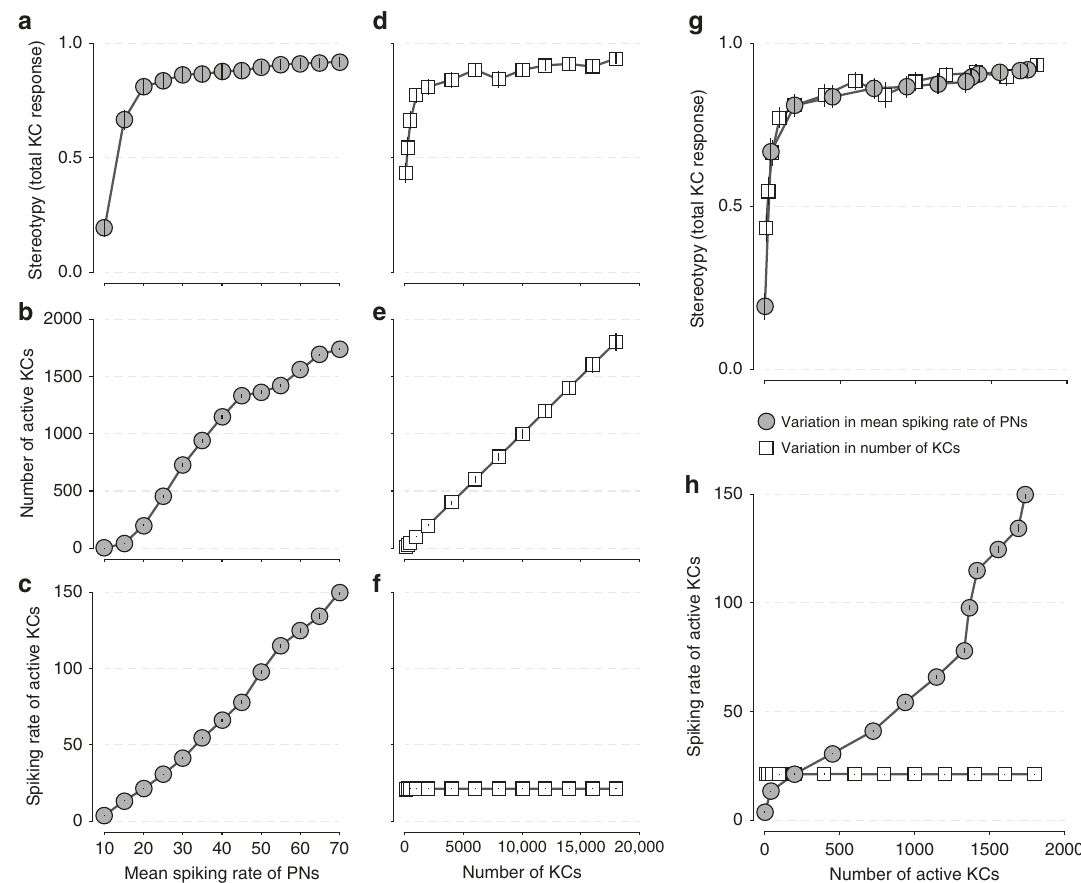
Fig. 6 The number of active KCs but not their spiking rate determines stereotypy. a – c Stereotypy in total KC response ( a ), average number of active KCs ( b ), and the average rate of active KCs ( c ) versus the mean spiking rate of PNs. In this set of simulations, the mean spiking rate of PNs was changed by changing the PN spiking range to the indicated mean ± 10. Note that in these simulations, both the average number of active KCs and their average spiking rate increase with the increase in mean PN spiking rate. d – f Stereotypy in total KC response ( d ), average number of active KCs ( e ) and the average rate of active KCs ( f ) versus the number of KCs in the model, when this number was changed to the indicated value in a separate set of simulations. Note that in these simulations, only the average number of active KCs but not their average spiking rate increases with the number of KCs. g , h Stereotypy in total KC response ( g ) and the rate of active KCs ( h ) versus the average number of active KCs in two sets of simulations described in the previous panels. Stereotypy increased equally in both sets of simulations with the number of active KCs and did not depend on the average spiking rate of KCs, which increased in the fi rst set but not in the second set. In all panels, n = 100 iterations; in each iteration, averages were taken over both odors and both individuals. Error bars represent